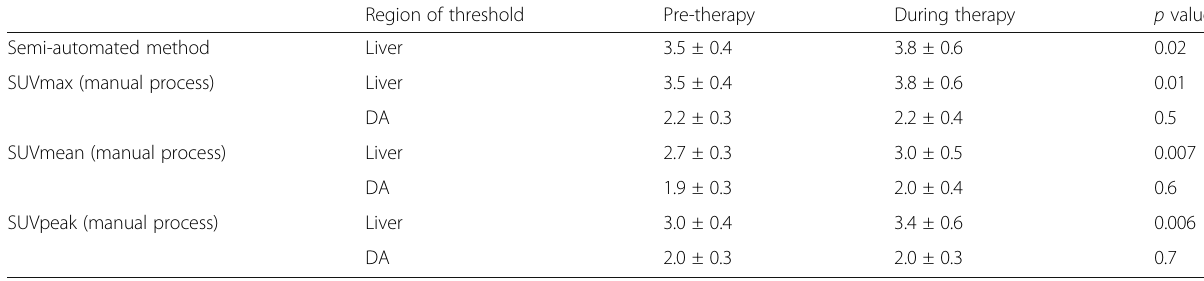
Table 3 SUV change pre- to during-steroid therapy Region of threshold